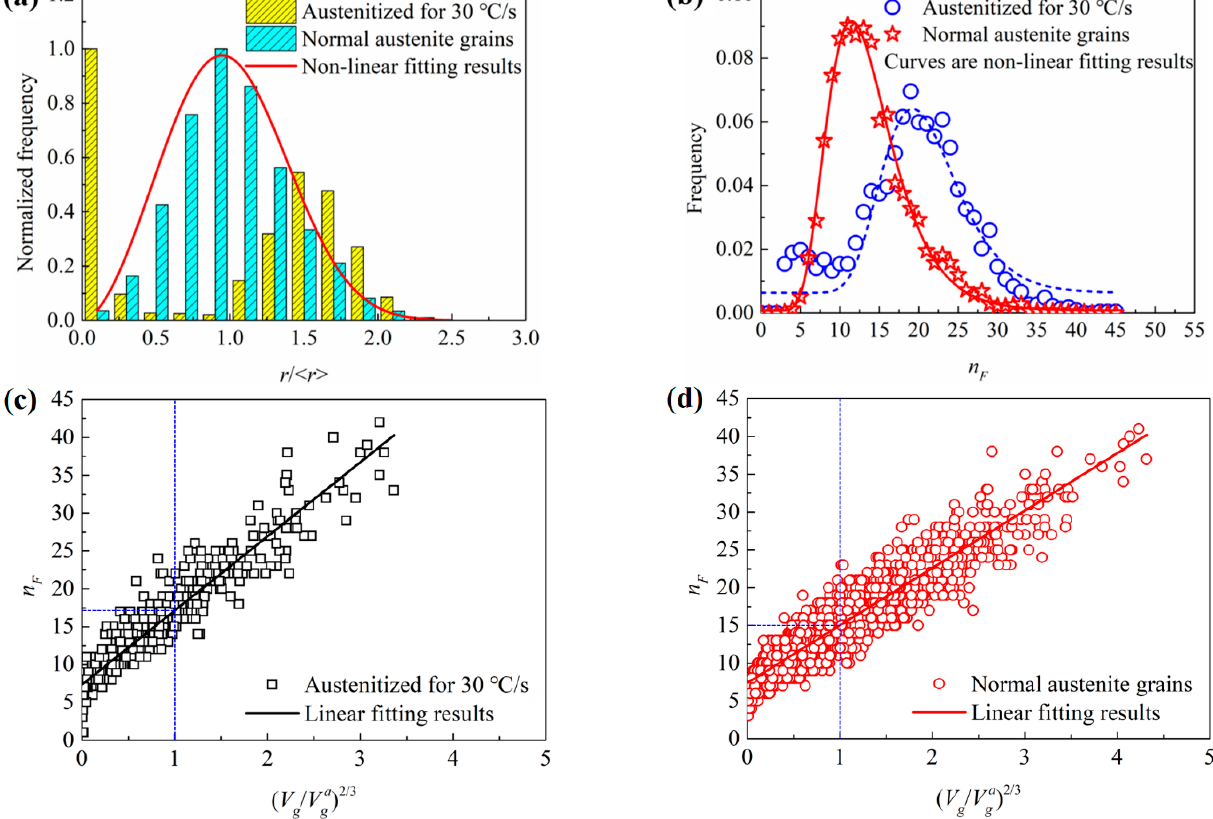
Figure 11. ( a ) Grain size distributions and ( b ) grain face number distributions of the grains austenitized for 30 °C /s and normal grains. Relationships between the grain face number and ( V g / V ga ) 2/3 of ( c ) the grains austenitized for 30 °C /s; and ( d ) the normal grains.